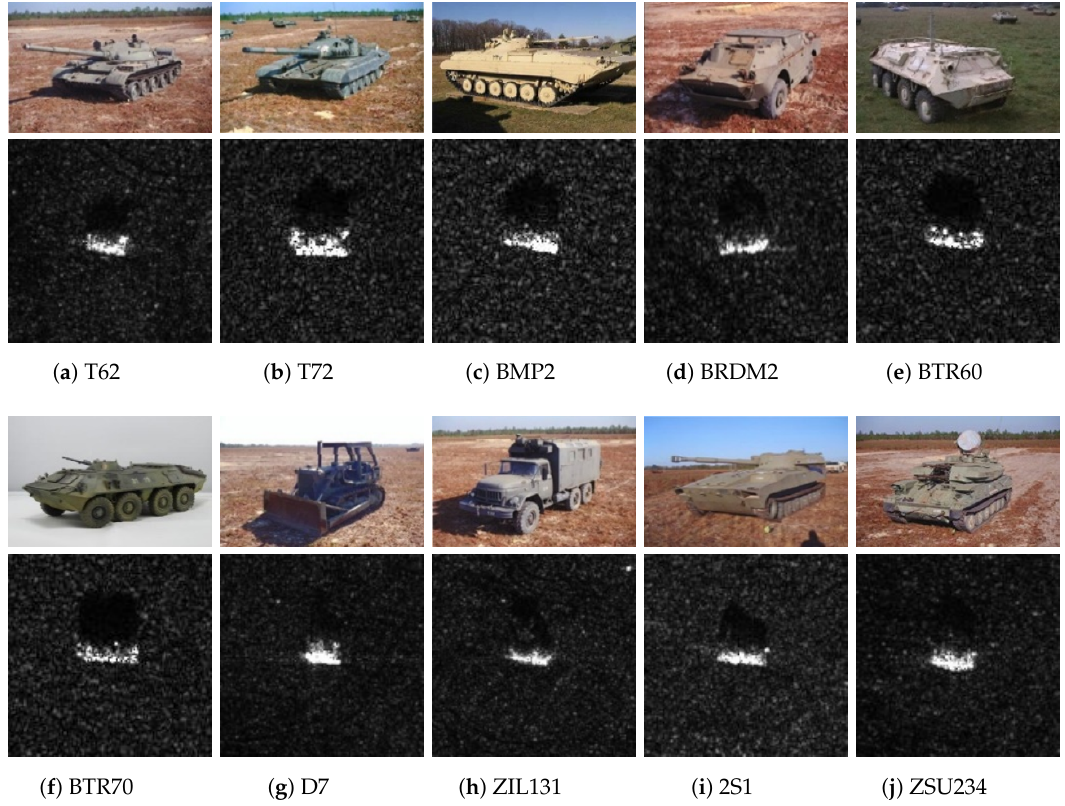
Figure 6. The optical and SAR images in the MSTAR